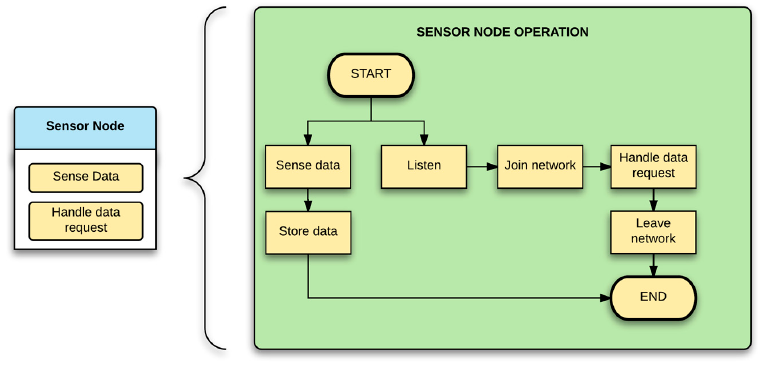
Figure 5. Sensor node’s task diagram.